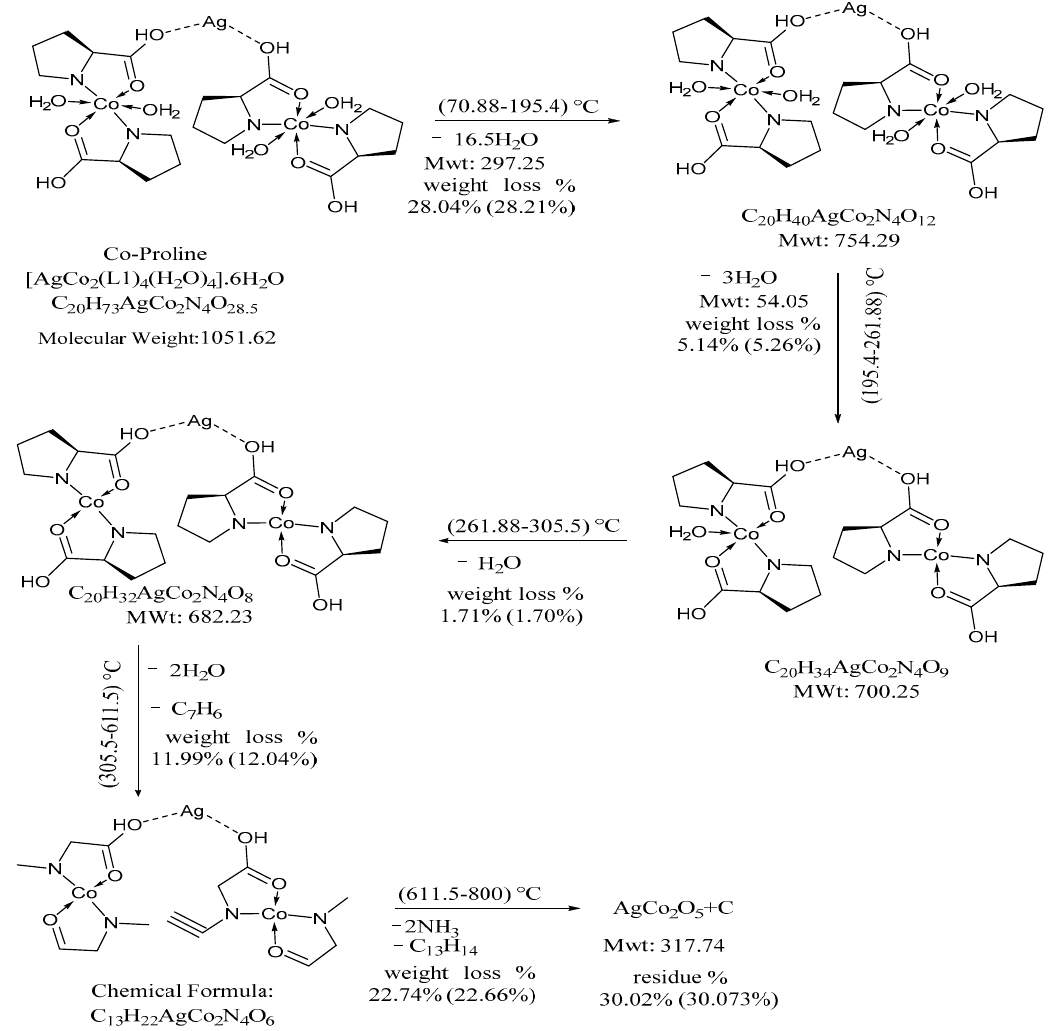
bled monolayer on Ag 0 NPs via strong Ag O covalent bond and Van der Waals interaction. The bond energy Ag-O is 217 kJ mol − 1 . There is a small difference in Δ H confirmed supra- molecular structure [33], see Scheme 3. supramolecular structure [33], see Scheme 3.